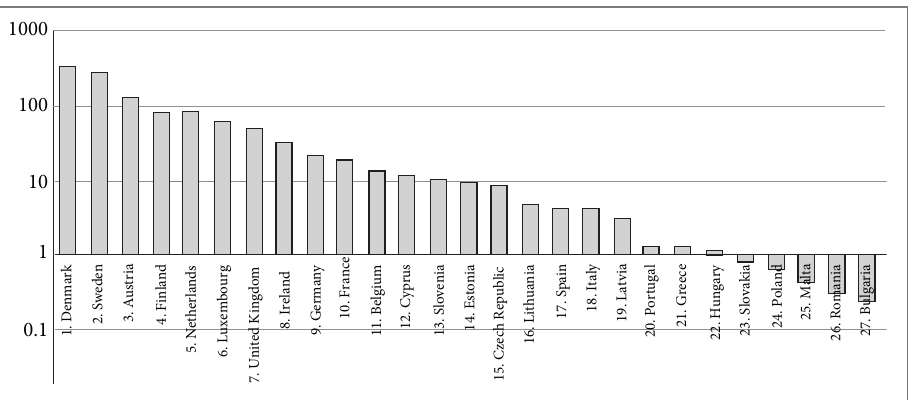
Fig. 4. Ranks given to European Union Member States according to Full Multiplicative Form method,